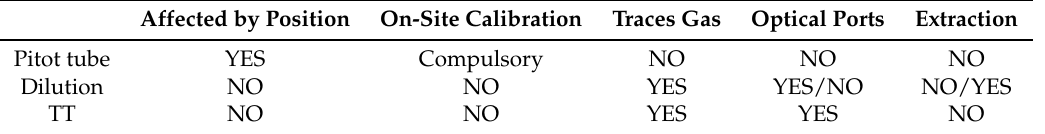
Table 2. Comparison of Pitot tube, TT and dilution